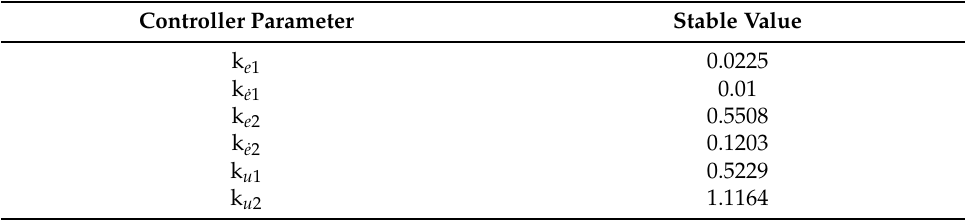
Table 5. Parameters of adaptive fuzzy controller based on PSO optimization.